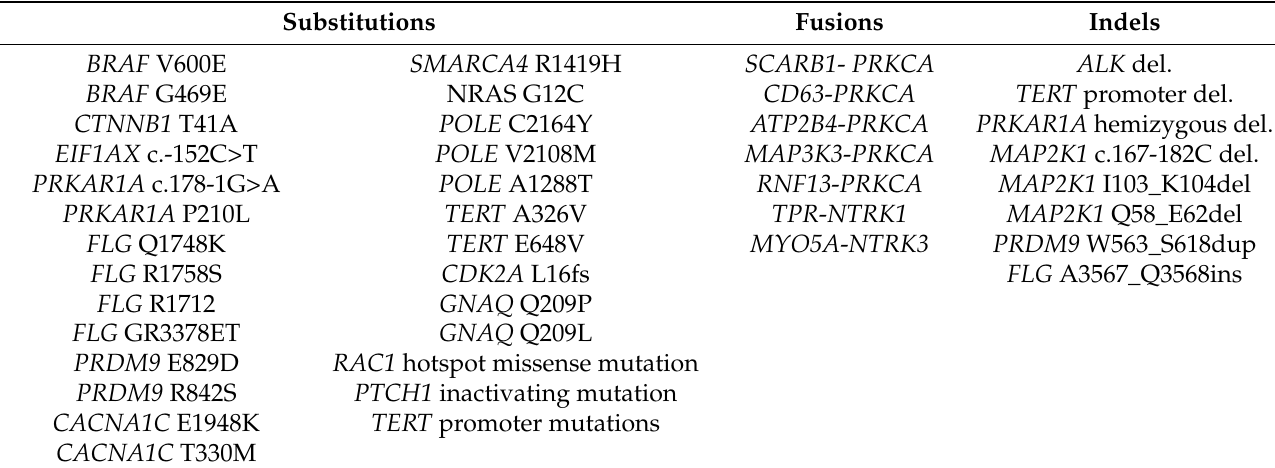
Table 1. Molecular alterations detected in